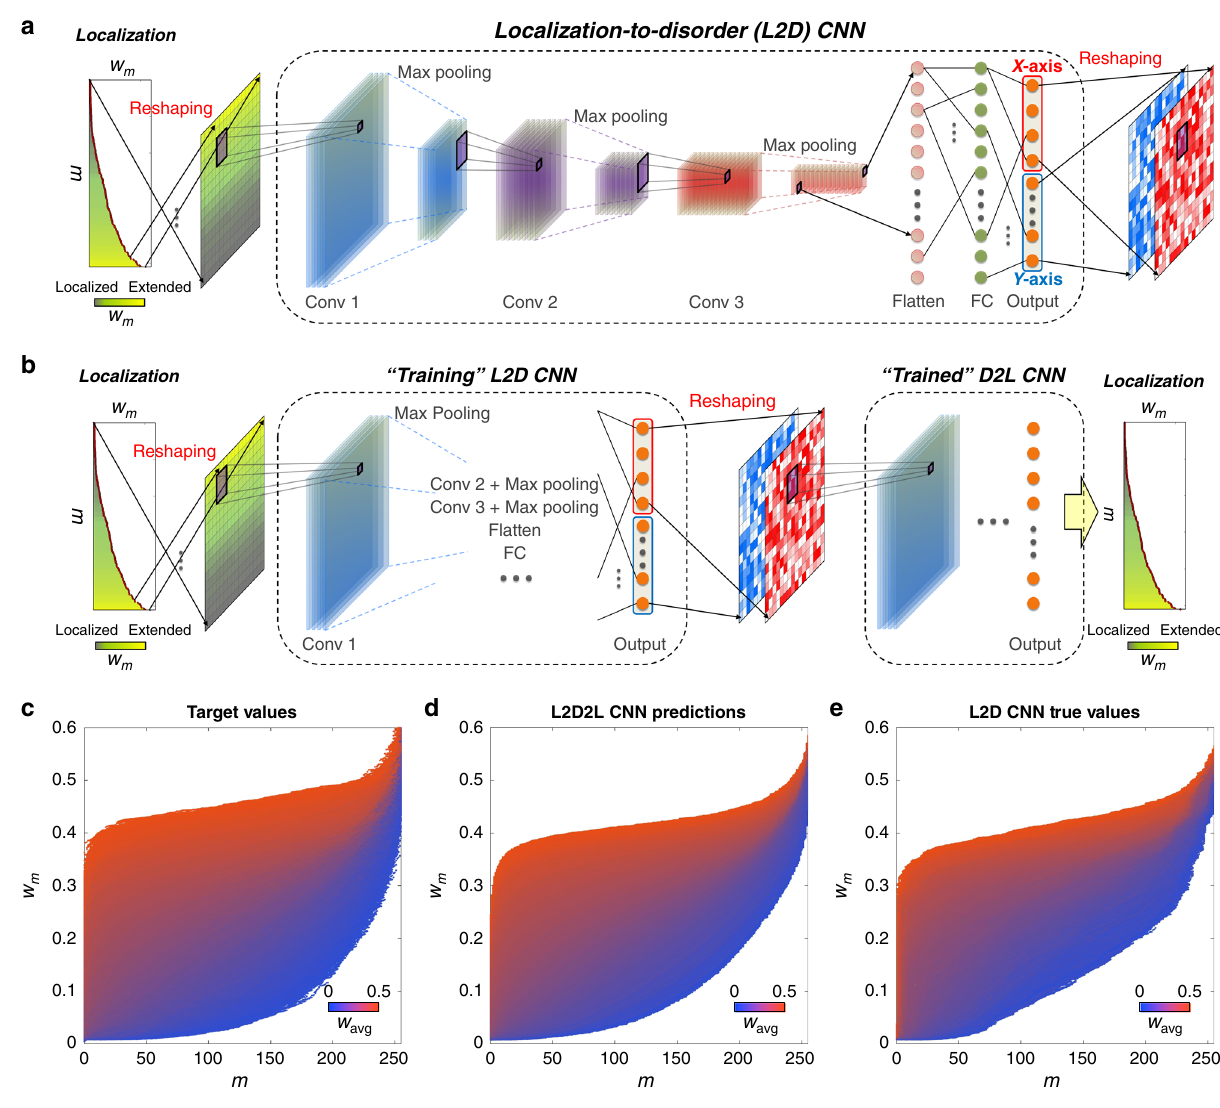
Fig. 3 Localization-to-disorder convolutional neural network for generating disordered structures. a The network structure of the localization-to- disorder (L2D) convolutional neural network (CNN). b The network structure of the localization-to-disorder-to-localization (L2D2L) CNN for training the L2D CNN with the pre-trained disorder-to-localization (D2L) CNN. The details of the network parameters are shown in the “ Methods ” section. c – e Comparisons of localizations between c the target values, d the machine-learning-predicted values from the L2D2L CNN, and e the Hamiltonian-calculated true values with the disordered structures generated by the L2D CNN for a broad range of average mode area w avg of the test data set (1 × 10 4